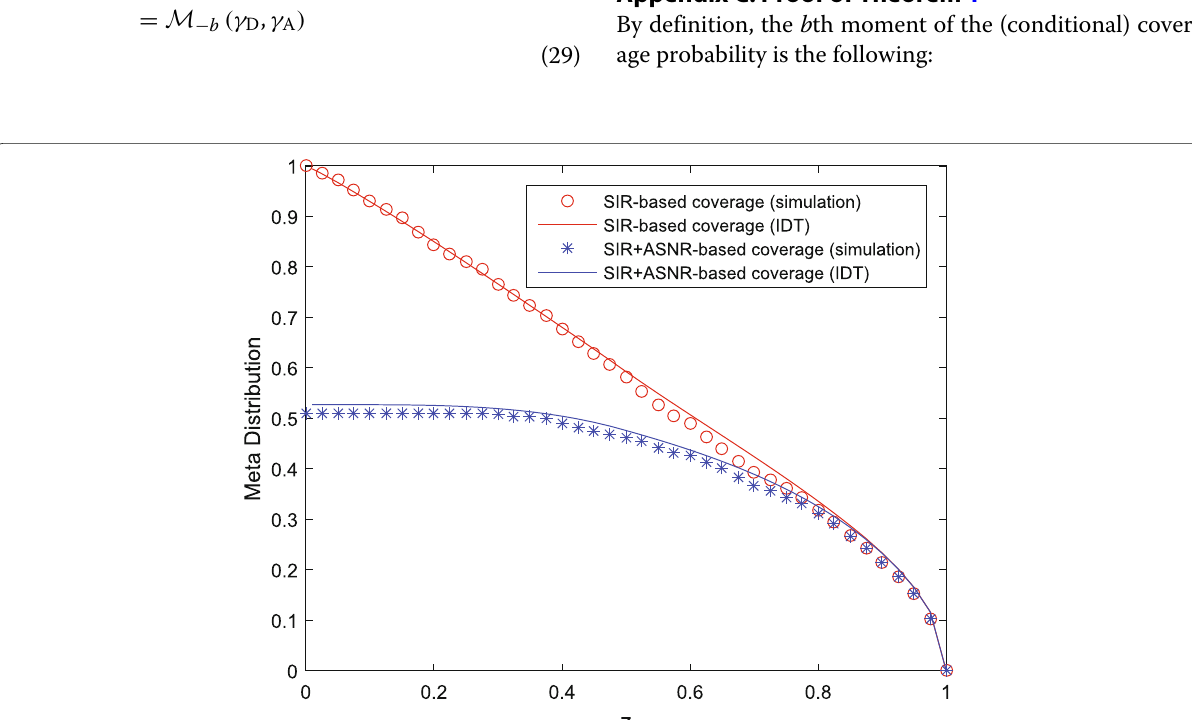
Fig. 2 Meta distribution: Comparison between the SIR-based and SIR + SNR-based definition of coverage (ASNR=SNR). Setup: Ginibre point process case. Solid lines: IDT framework. Markers: Monte Carlo